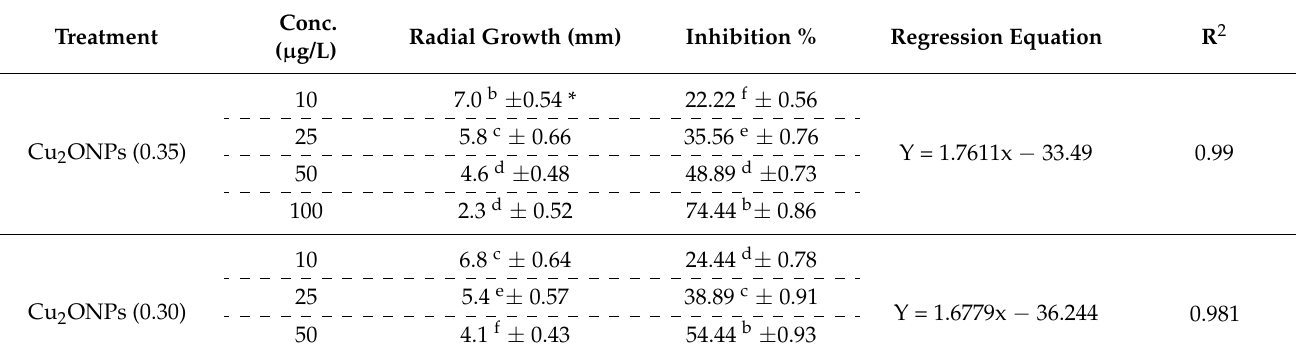
Table 2. Radial growth and inhibition percentage of the Cu 2 ONPs and fungicide against F. solani in vitro with regression equation and degree of